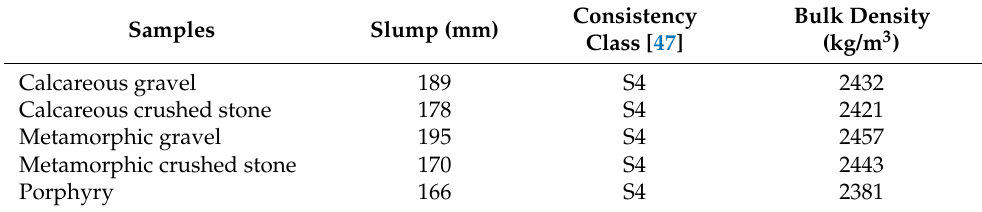
Table 15. Data value of slump (expressed in mm) and bulk density (expressed in kg/m 3 ) of the fresh concrete samples.